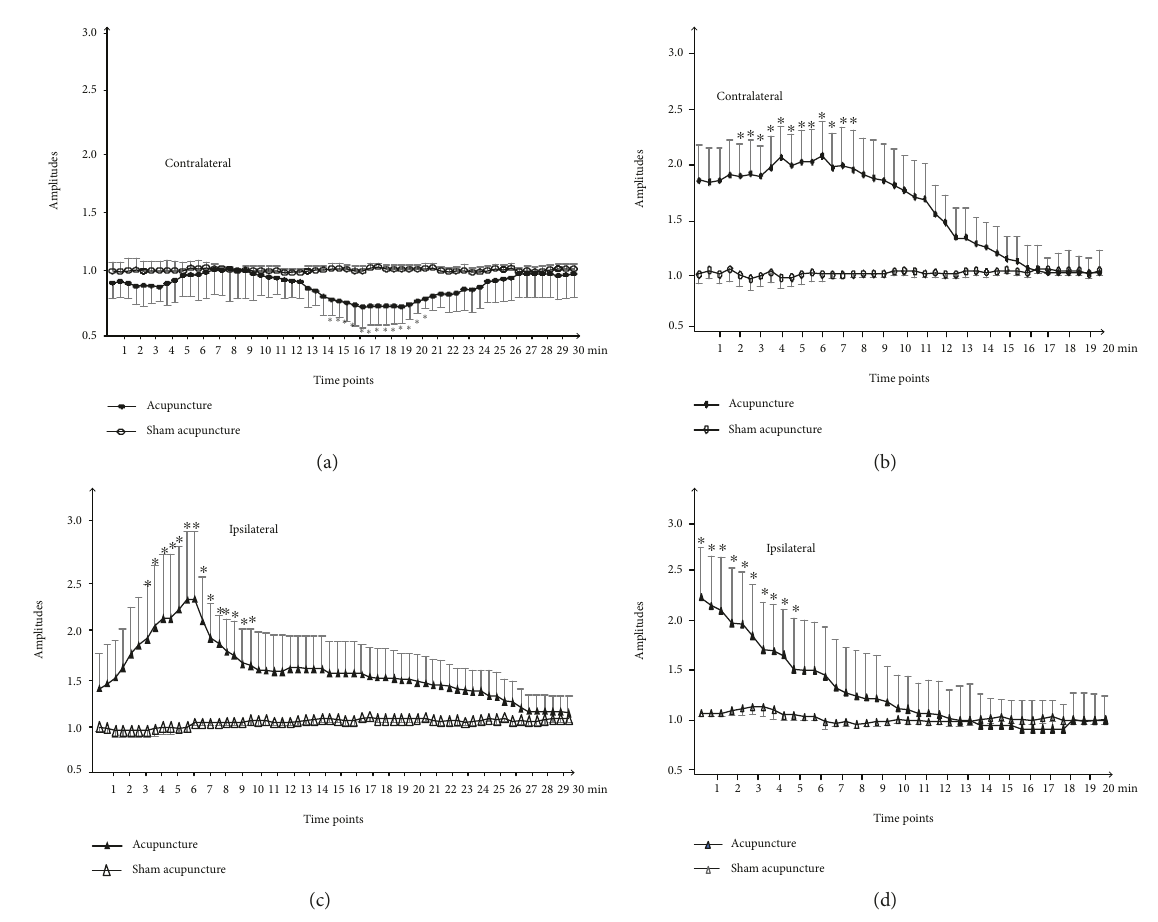
Figure 2: E ff ects of the acupuncture on MEP amplitude. (a) Amplitude changes of MEPs in FDI muscles following the needle insertion in situ on the contralateral hemisphere of the acupuncture sites. (b) Amplitude changes of MEPs in FDI muscles after the needle removal from the in situ on the contralateral hemisphere of the acupuncture sites. (c) Amplitude changes of MEPs in FDI muscles following the needle insertion in situ on the ipsilateral hemisphere of the acupuncture sites. (d) Amplitude changes of MEPs in FDI muscles following the needle insertion in situ on the ipsilateral hemisphere of the acupuncture